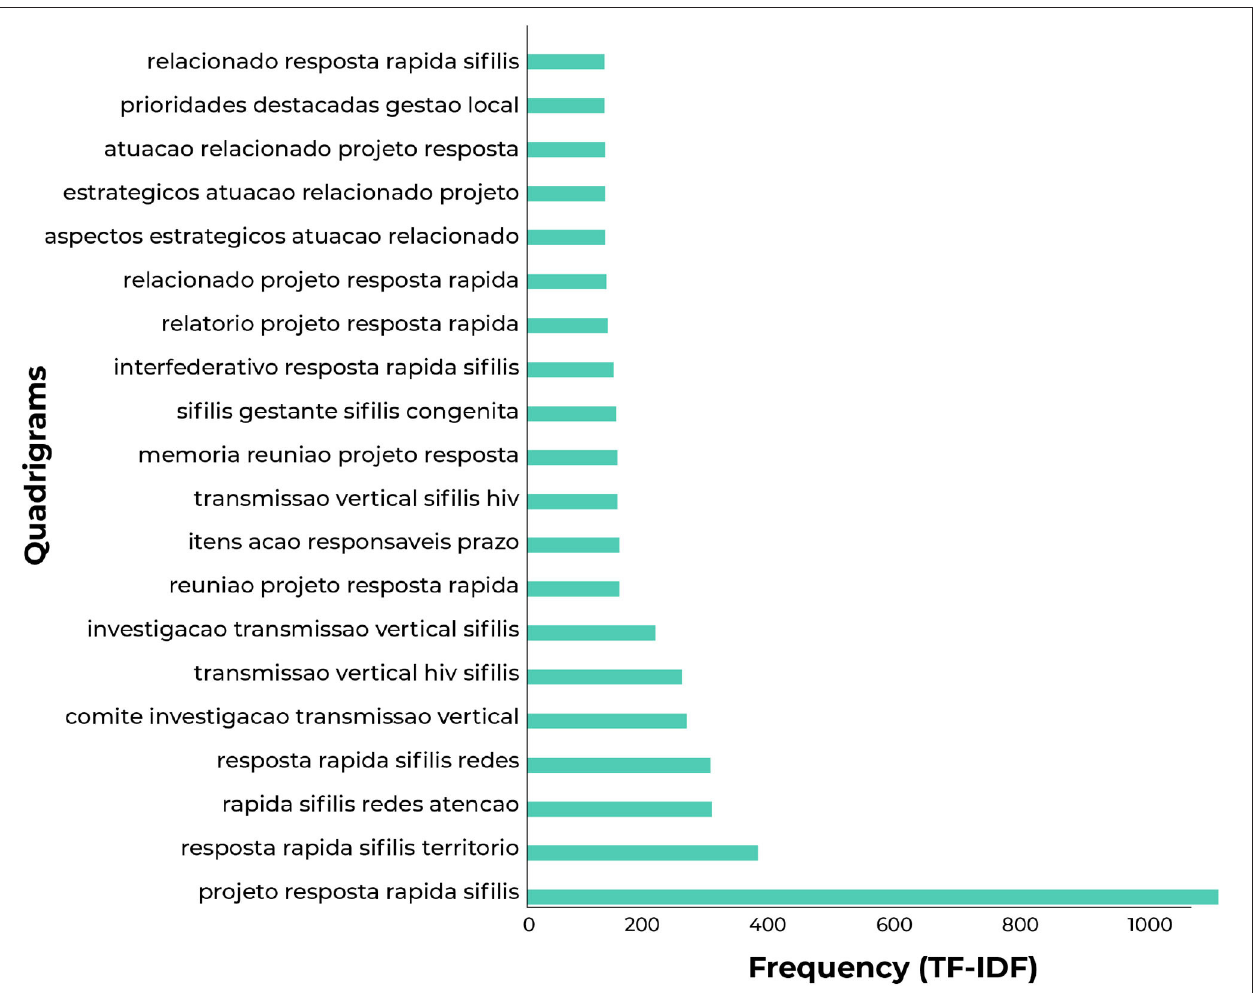
FIGURE 9 | The 20 most common quadrigrams in